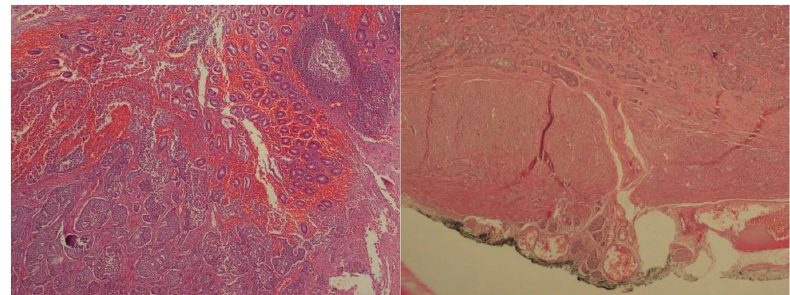
Figure 5: In hematoxylin and eosin sections, tumoral tissue infiltrating the appendix mucosa and submucosa and developing in the insular pattern is observed on the left side of the picture. In the right half of the picture, it is seen that the tumoral tissue infiltrates the submucosa, as well as the muscularis propria and subserosa.